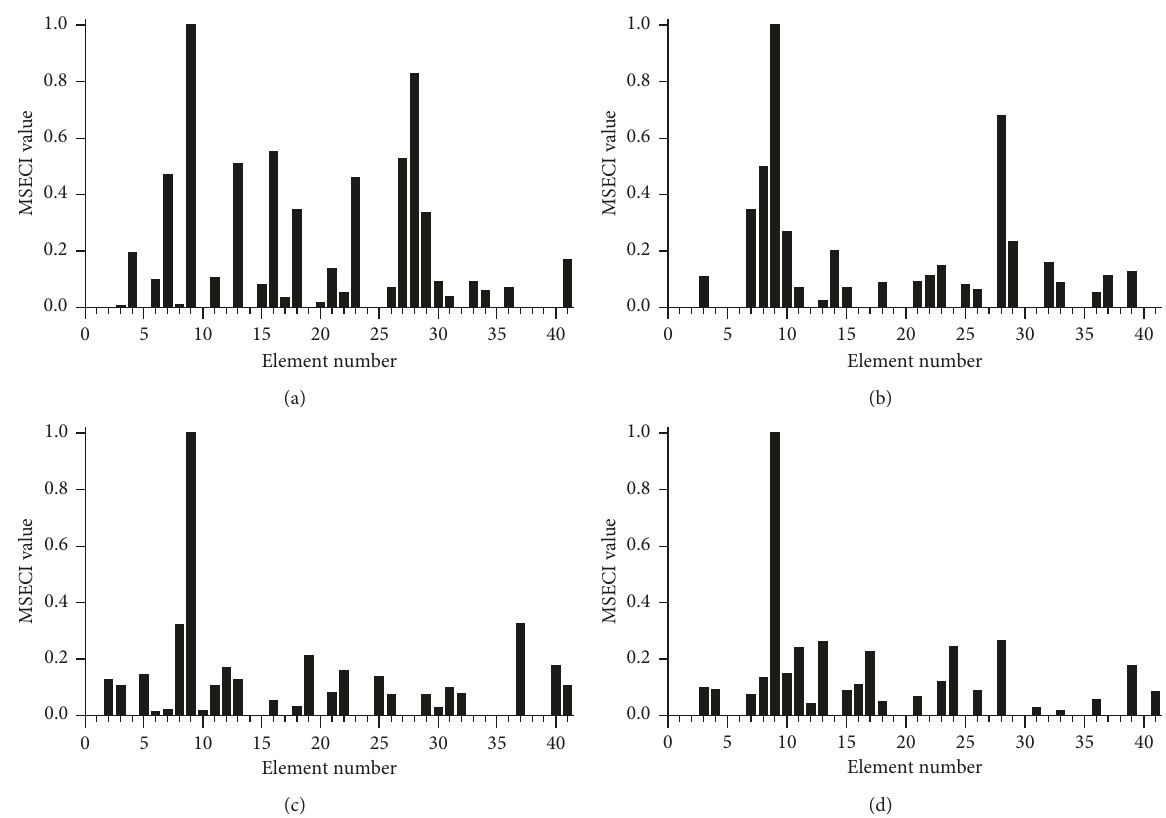
Figure 7: Values of the proposed MSECI using the first several modes together (damaged element 9, with 5% noise). (a) Using modes 1-2. (b) Using modes 1–4. (c) Using modes 1–6. (d) Using modes